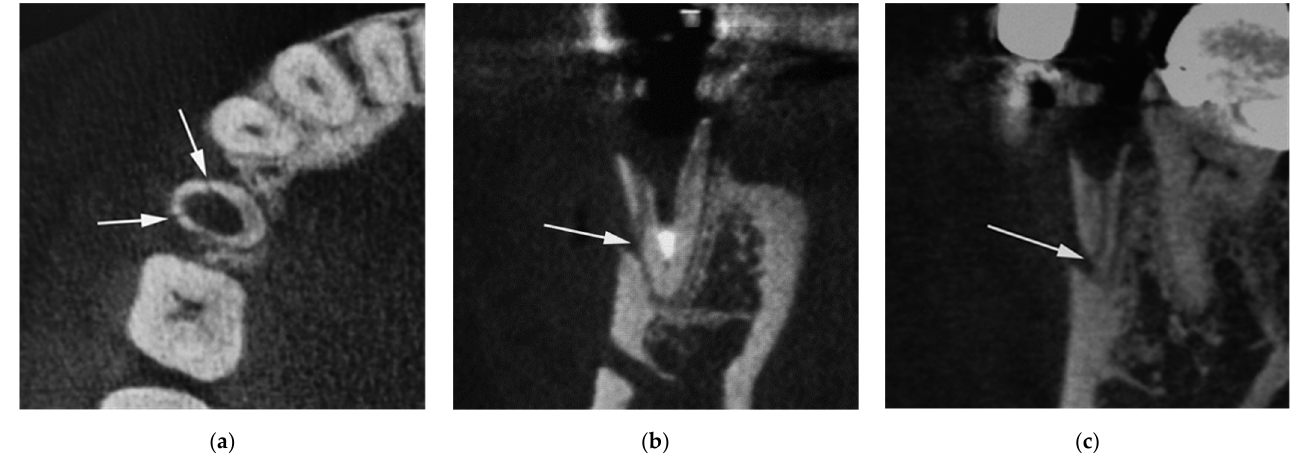
Figure 2. CBCT image of vertical root fractures in endodontically treated teeth (mesio-distal fracture). ( a ) Axial image; ( b ) cross ‐ sectional MPR image; ( c ) parasagittal MPR image. Arrow indicates part of root fracture.